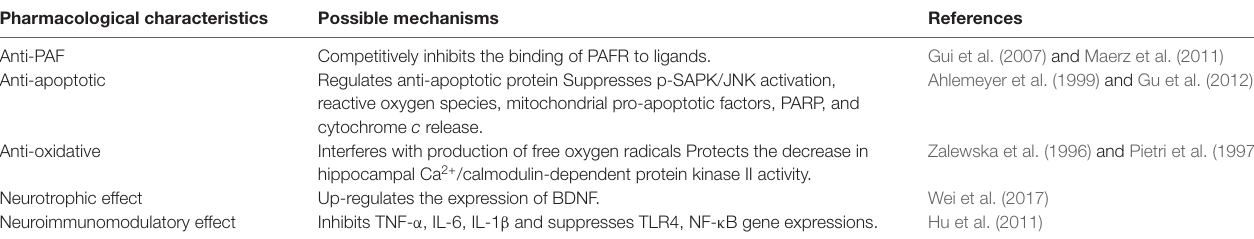
TABLE 1 | Pharmacological characteristics of ginkgolides.